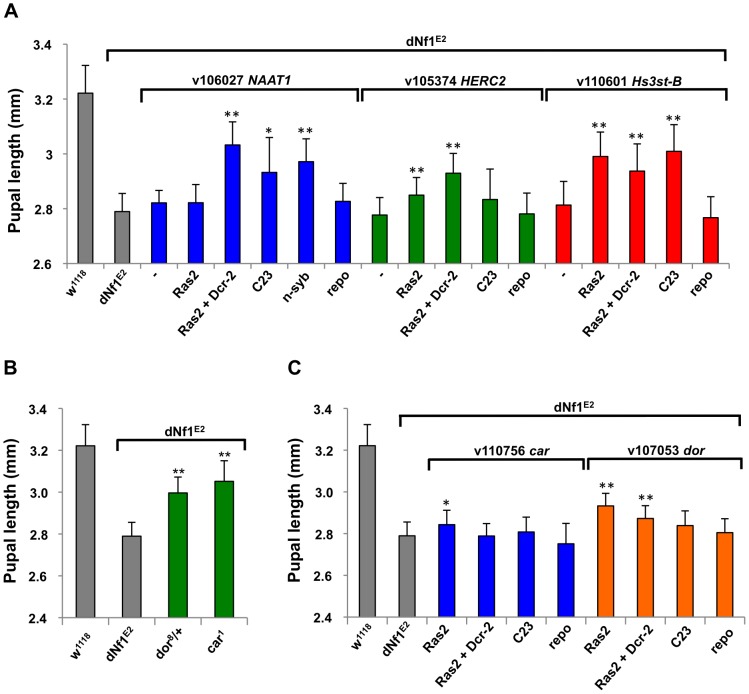
Identification of modifying genes with undetermined roles in dNf1 suppression.(A) Validation of NAAT1, HERC2 and Hs3st-B as dNf1 modifiers. All three genes were identified by systematic RNAi screening of genes uncovered by suppressing deficiencies. (B) Loss-of-function alleles of Class C Vacuolar Protein Sorting complex subunits carnation (car/Vps33A) and deep-orange (dor/Vps18) increase dNf1 pupal size. C) RNAi-mediated neuronal car or dor knockdown was not particularly effective, suggesting these genes may function elsewhere to modify dNf1-dependent growth.